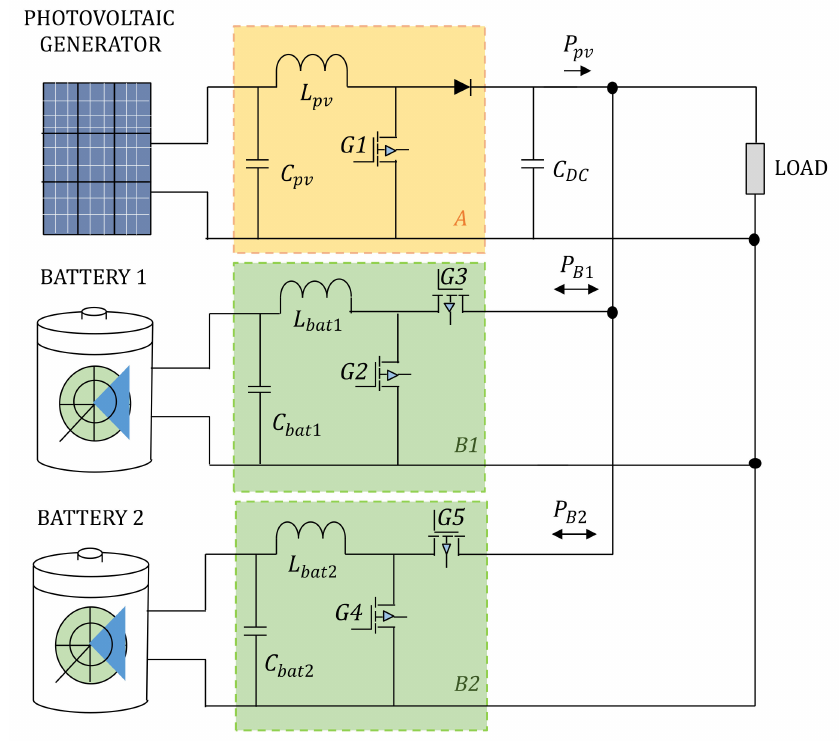
Figure 1. Schematic of an isolated DC microgrid.